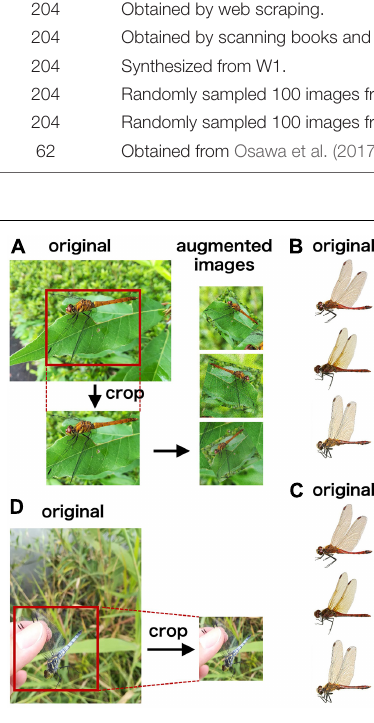
TABLE 1 | Description of datasets. Dataset